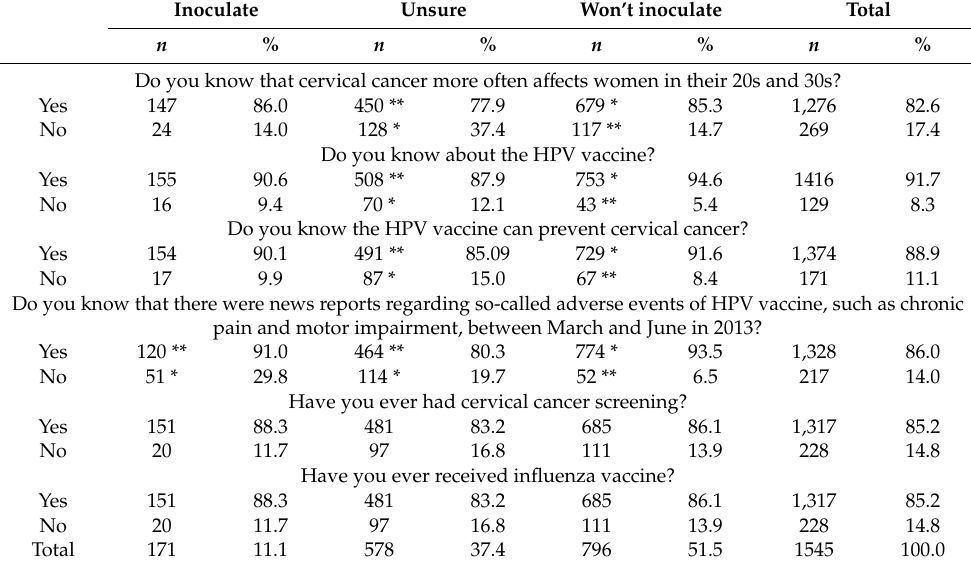
Table 2. Correlation between questions and intention of mothers to inoculate daughter under current circumstances. Inoculate Unsure Won’t